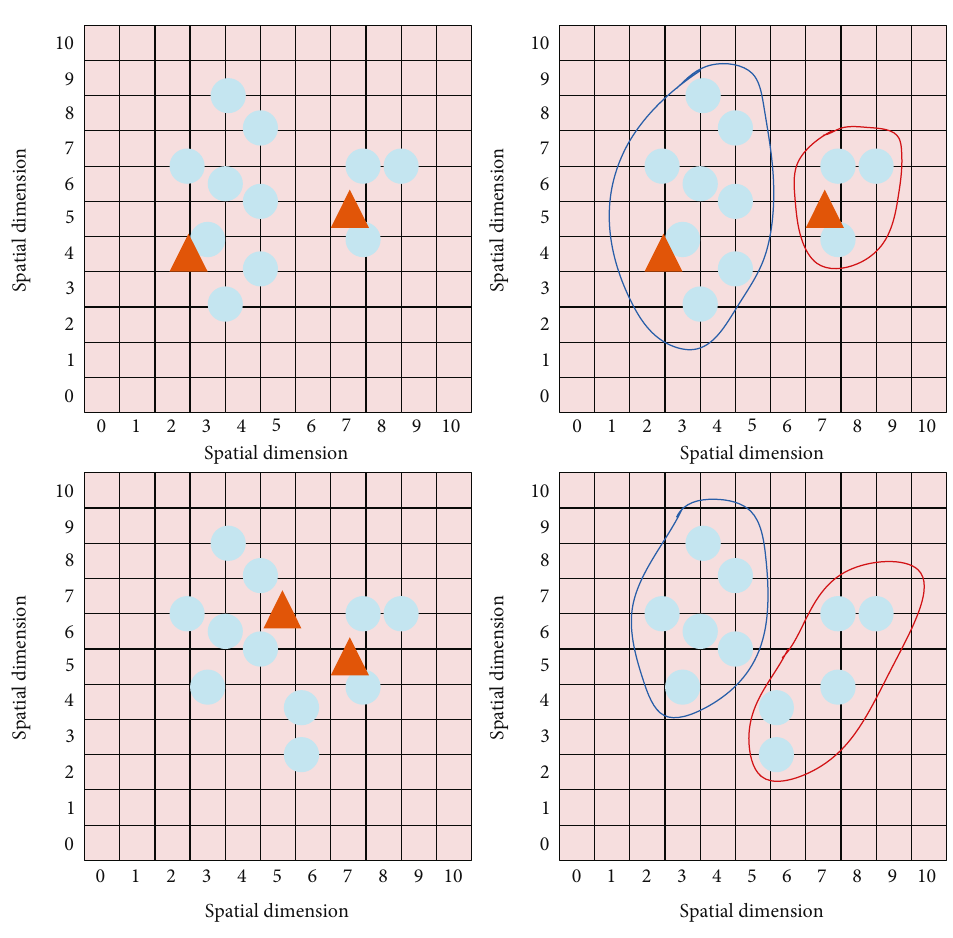
Figure 5: Clustering